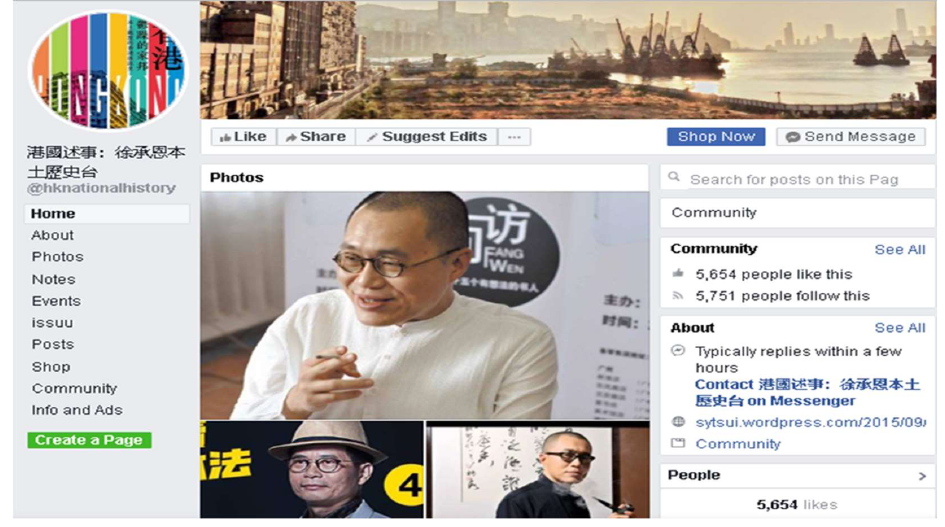
Figure 1. A Screenshot of Fan Page of HNH.